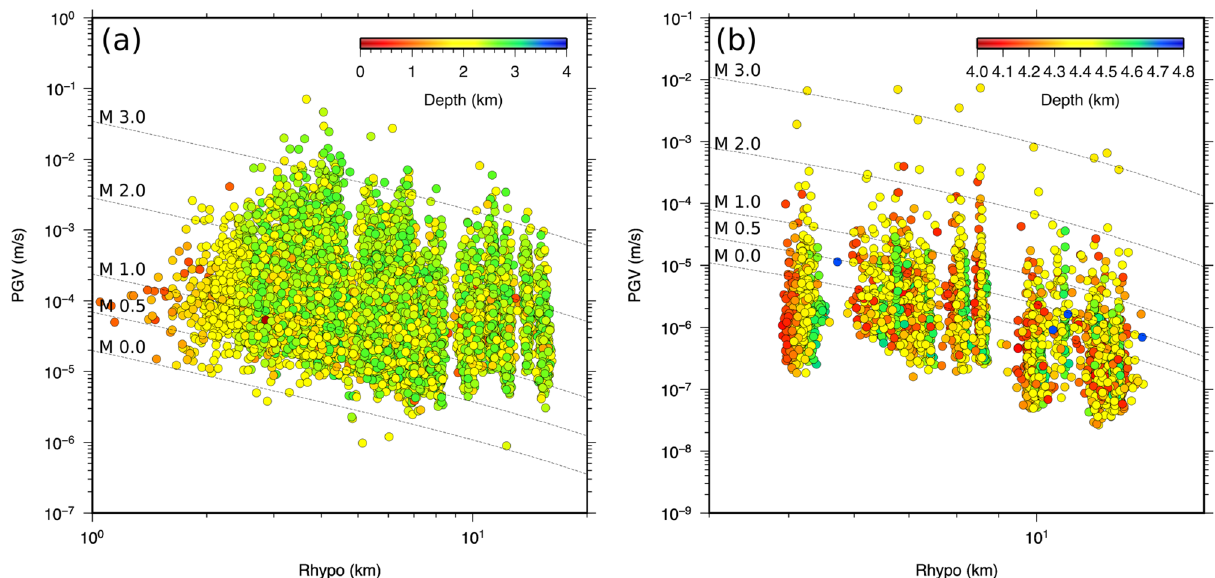
Figure 4. Peak-ground velocity distribution. ( a ) PGVs distribution as function of the hypocentral distance for The Geysers geothermal field. The values are colour coded according to the depth of the earthquake. The dashed lines represent the inferred reference GMPE for four magnitude values. ( b ) Same as panel ( a ) but for St. Gallen geothermal